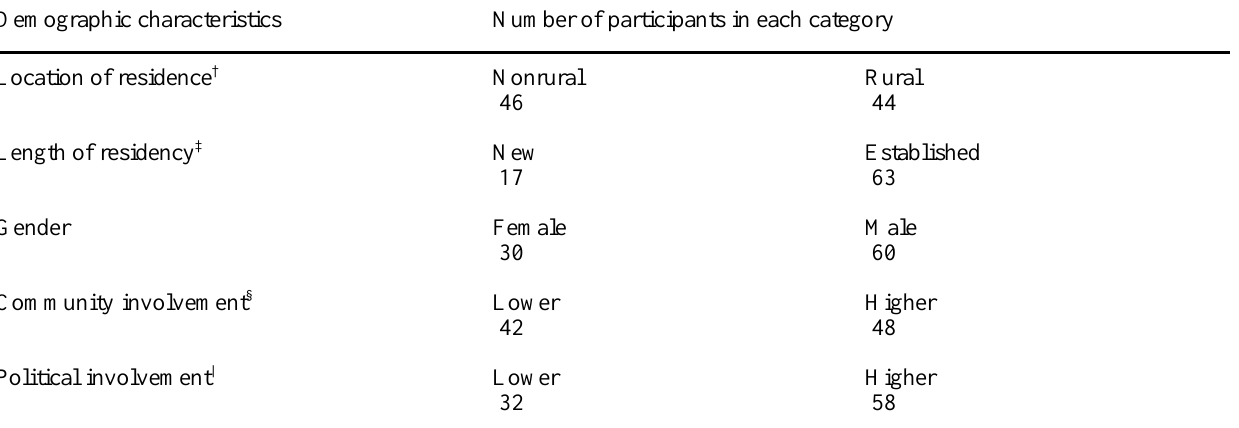
Table 5 . Categories of demographic characteristics of interview